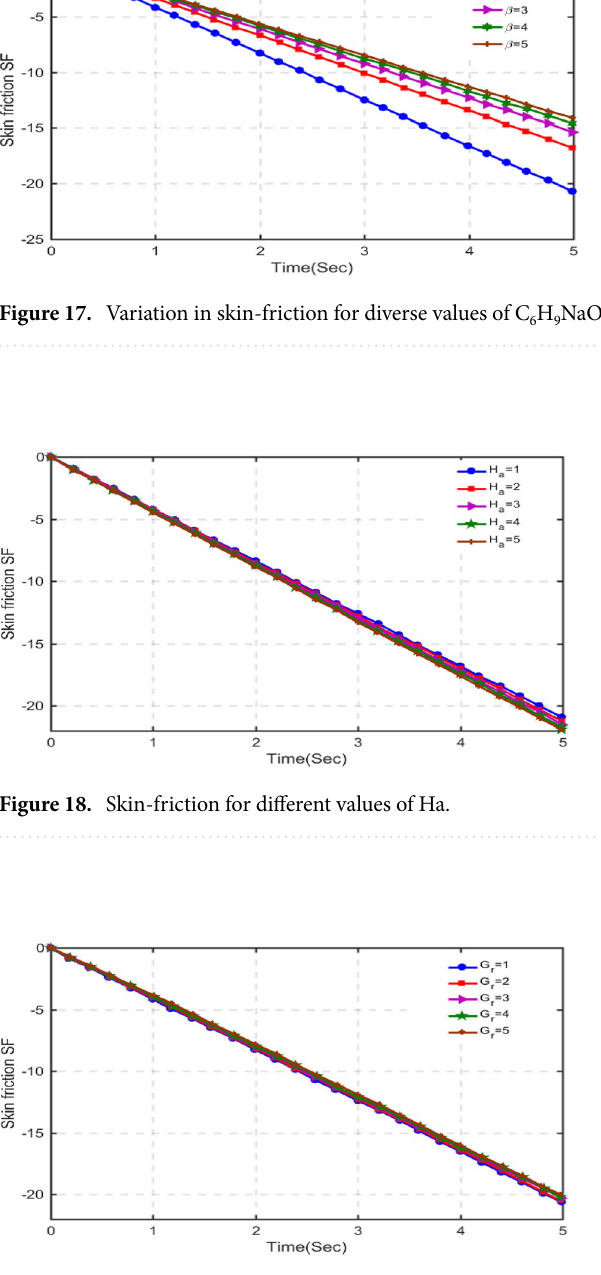
Figure 19. Skin-friction for different values of Gr .